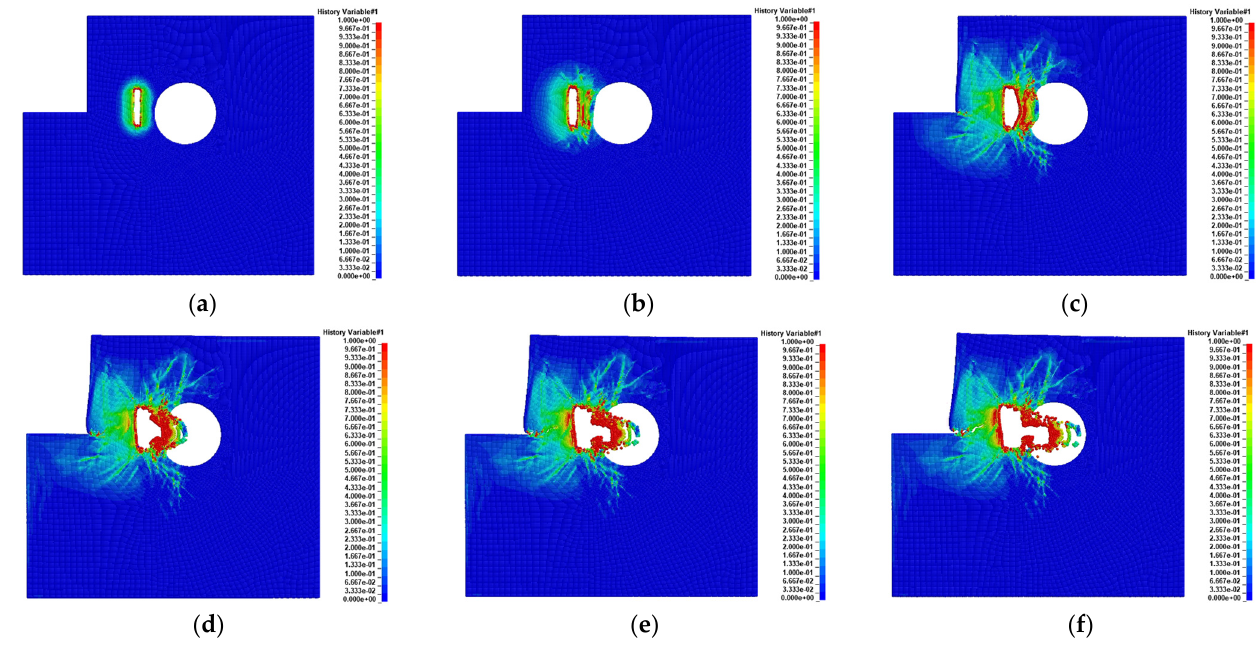
Figure 10. Rock-blasting effect of rock blasting with karst cavity. ( a ) t = 350 μ s; ( b ) t = 750 μ s; ( c ) t = 2 × 10³ μ s; ( d ) t = 4 × 10³ μ s; ( e ) t = 6000 μ s; ( f ) t = 8 × 10³ μ s.